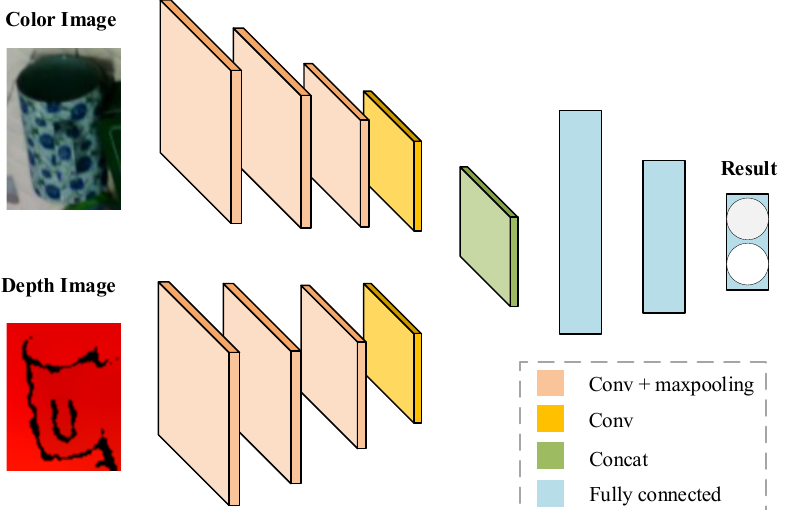
Figure 6. The overall framework of the classification network. Two convolutional networks are designed to extract color and geometric features, respectively, then fuse those features, and utilize fully connected layers to obtain